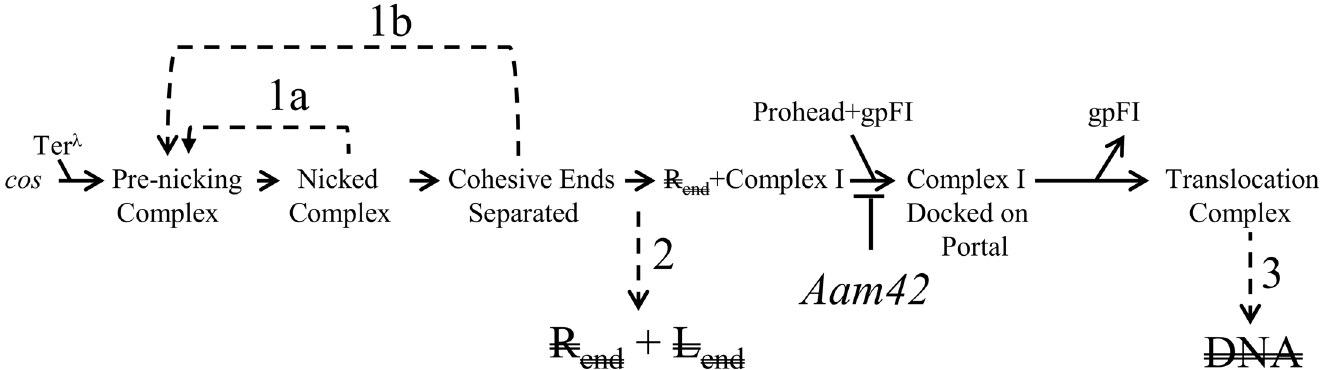
Fig 7. Early DNA packaging steps at which I2 might act. Four steps at which an I2 defect might interrupt DNA packaging are numbered. The step blocked for Aam42 terminase is also indicated. Model 1a: Failure to separate the newly created cohesive ends, followed by dissociation of terminase, and re-ligation that reseals the nicks. Model 1b: Reannealing of the cohesive ends followed by religation. Model 2: I2 mutations block formation of, or destabilize, Complex I. Note that accompanying Complex I formation, the R end DNA end is released and subject to exonuclease digestion; this is indicated by R end . Model 3: I2 mutations interfere with proper threading of the DNA through the motor assembly so that the DNA is translocated into the cytoplasm and is subject to exonuclease digestion. DNA represents the nuclease-susceptible virion DNA. The Aam42 defect is the absence of an intact prohead binding domain at the C-terminus of TerL, which prevents Complex I from docking on the portal and assembling an active motor [35, 49, 50].